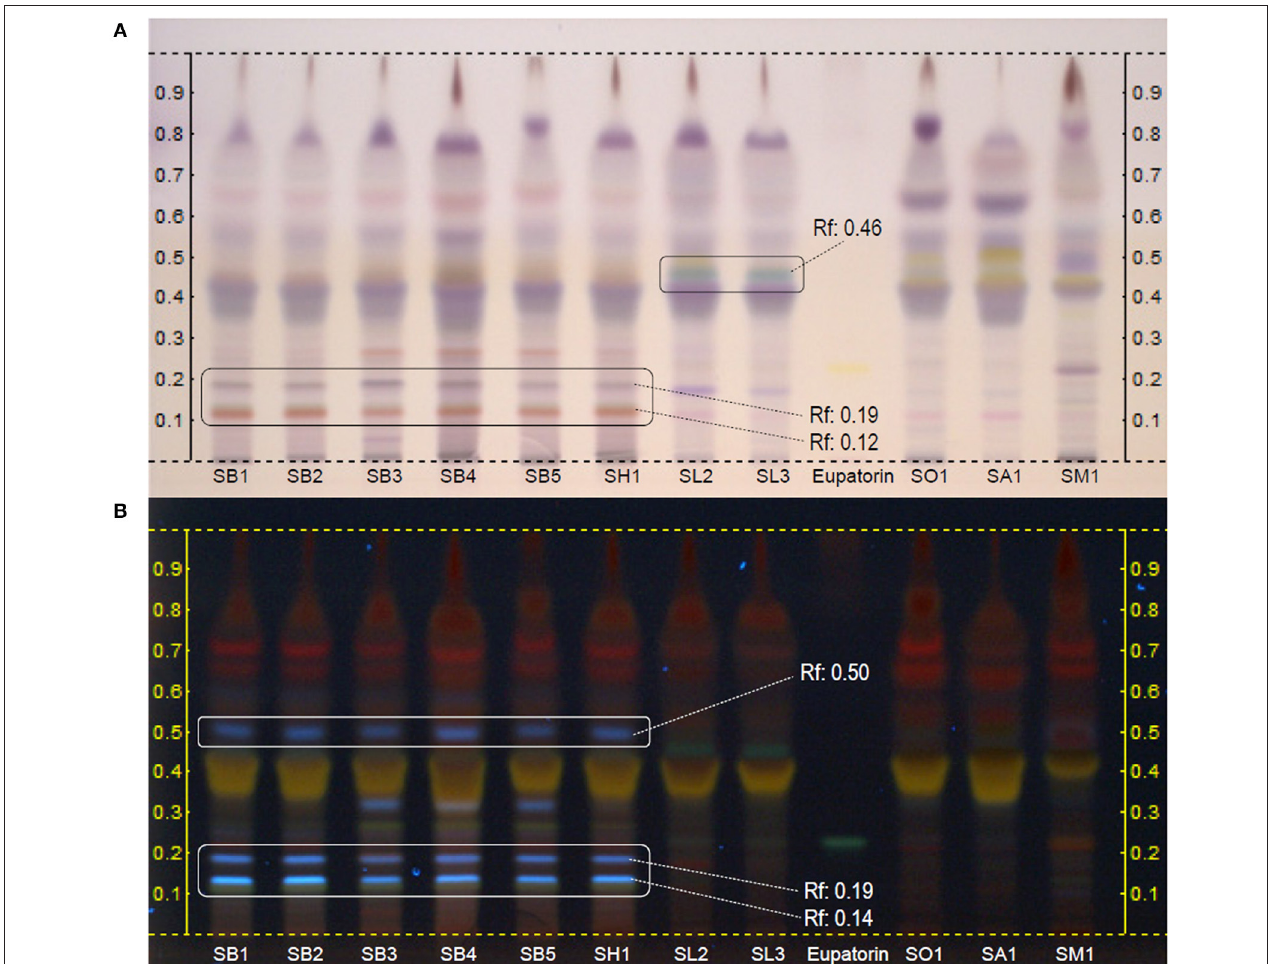
FIGURE 3 | HPTLC fingerprints of dichloromethane extracts of the aerial parts of Salvia species used in Valencian folk medicine. Mobile phase : Toluene:ethyl acetate:formic acid (70:30:1). Derivatization : anisaldehyde reagent. Visualization: white light (A) and UV 366 nm (B) . Track identification: SB1 to SB5, S. blancoana subsp. mariolensis ; SH1, S. x hegelmaieri ; SL2 and SL3, S. officinalis subsp. lavandulifolia ; SO1, S. officinalis subsp. officinalis ; SA1, S. x auriculata ; SM1, S. microphylla var.